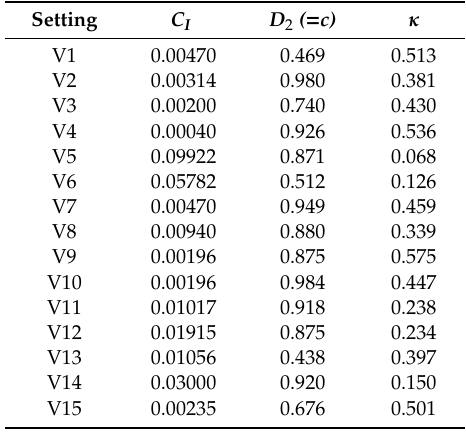
Table 2. Results for the parameter fitting to the model (4 for DoE